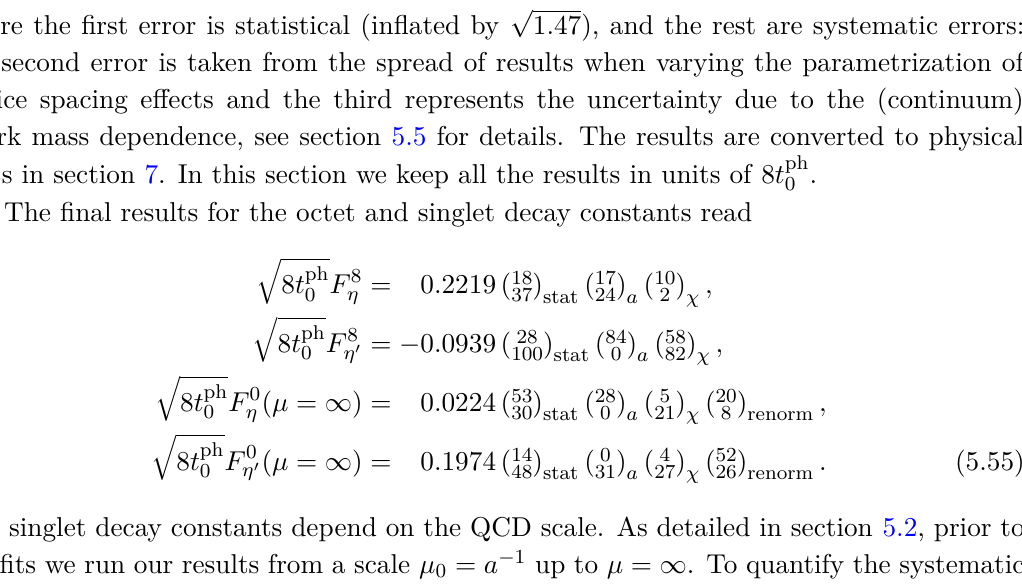
and n M . This η η 0